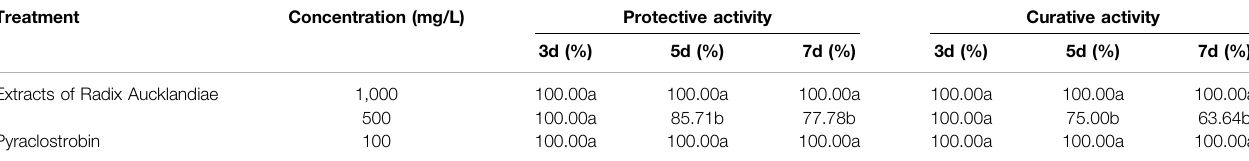
TABLE 4 | RDCE of extracts of Radix Aucklandiae on strawberry grey mould in vivo